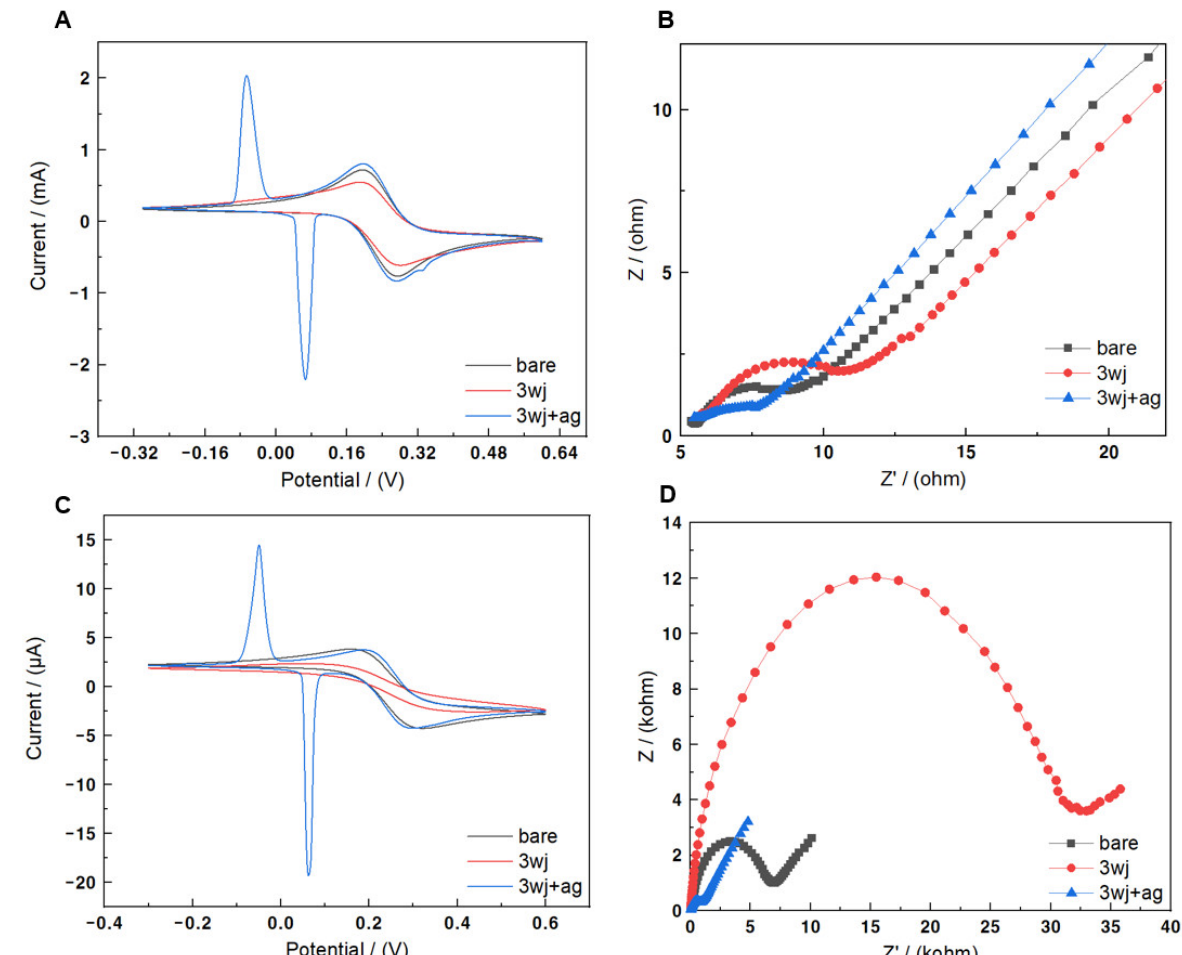
Figure 4. ( A ) Cyclic voltammogram of Au substrate (black line), MF-3WJ on Au substrate (red line), and MF-3WJ intercalated with Ag + on Au substrate (blue line). ( B ) Electrochemical impedance spectra of different modified Au substrates with bare, MF-3WJ, and MF-3WJ/Ag ion. ( C ) Cyclic voltammogram of Au microgap electrode (black line), MF-3WJ on Au microgap electrode (red line), and MF-3WJ intercalated with Ag ions on Au microgap electrode (blue line). ( D ) Electrochemical impedance spectra of different modified Au microgap electrodes with bare, MF-3WJ, and MF-3WJ/Ag ions. Working solution: 10 mM HEPES (pH 7.03) and 5 mM K 3/4 Fe(CN) 6 .